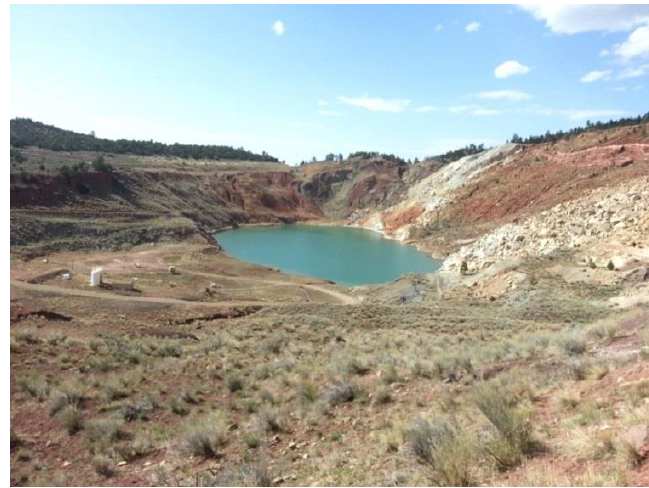
Figure 15. Nacimiento Mine site, near Cuba, New Mexico, USA. 2016 photo. Fossil wood can be collected from mine dumps bordering the water-filled open pit mine.